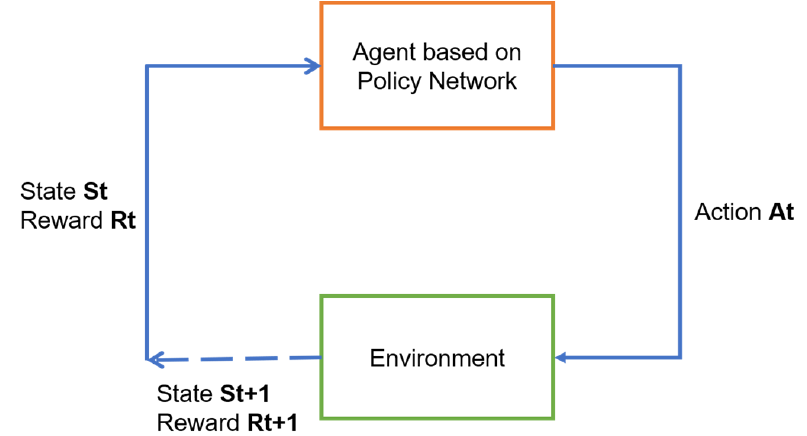
Figure 8. RL learning environment interaction.